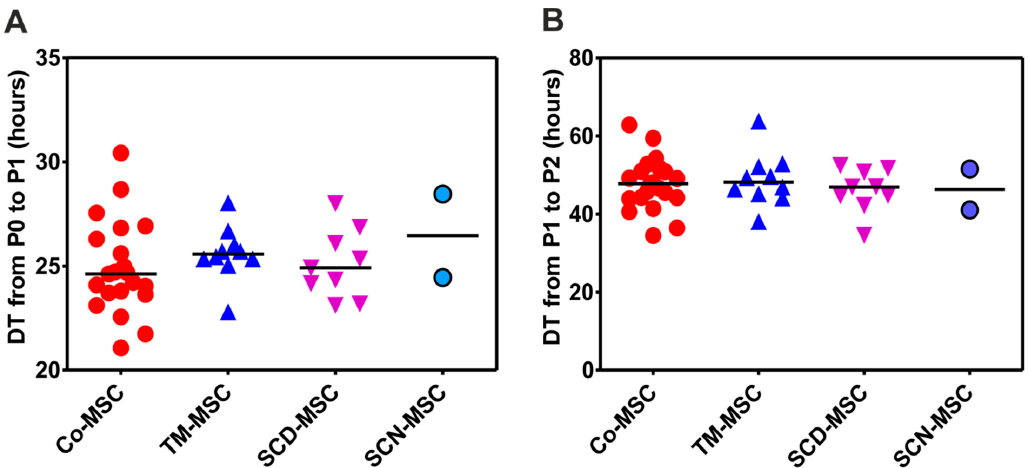
Figure 2. Proliferation potential of MSCs from different study groups at P0/P1 and P1/P2. ( A ) Time